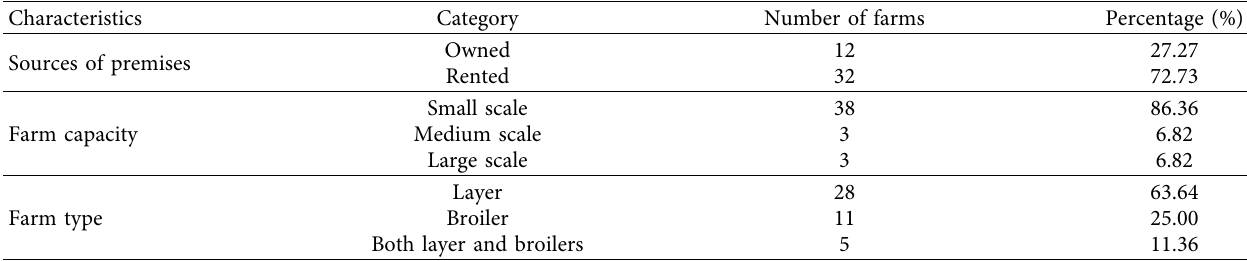
Table 2: The frequency and percentage of chicken farms by various farm characteristics.